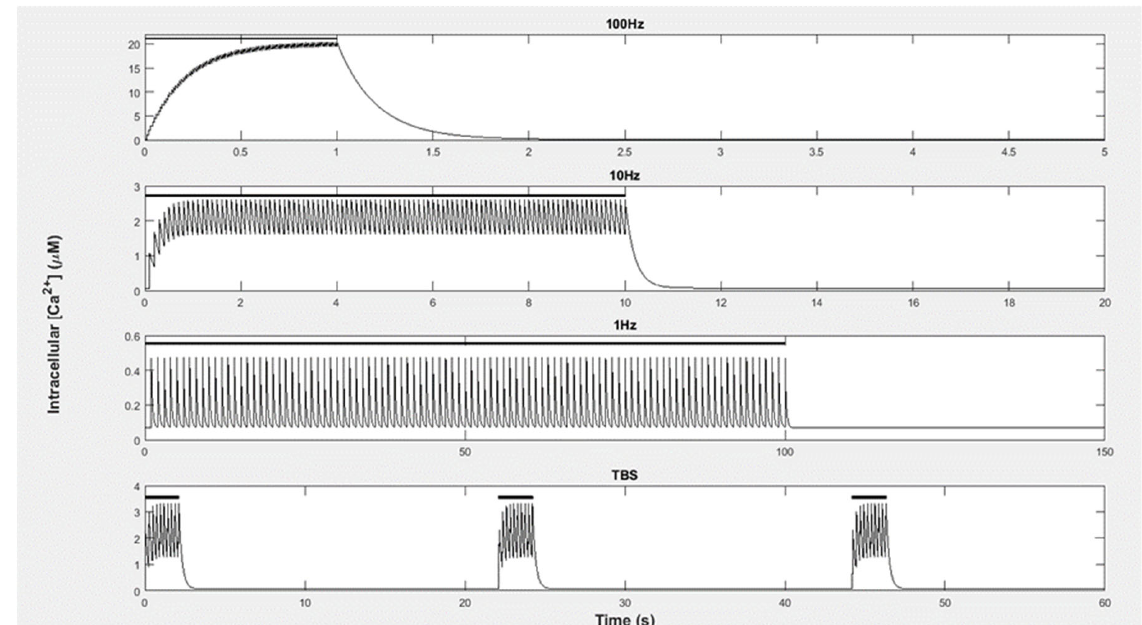
Figure 4. The Ca 2+ level in response to the stimulation trainings (as indicated by the black line above the y ‐ axis) to 100 pulses per second (100 Hz), 10 pulses per second (10 Hz), and one pulse per second for LFS (1 Hz) and the more complex training of the TBS pulses: Each of the 3 trainings consisted of pulse pattern consisting of 10 epochs. Each epoch contained 4 pulses separated by 10 ms (100 Hz) and each epoch of the training was separated by 0.2 s. Furthermore, each training was separated by 20 s. In each of the stimulations, it can be observed how the Ca 2+ decayed between each pulse and, as a consequence, if the pulses were closer together, then the Ca 2+ could accumulate before the previous pulse decayed. At LFS, each pulse almost completely decayed between each stimulation and, therefore, the Ca 2+ did not accumulate.